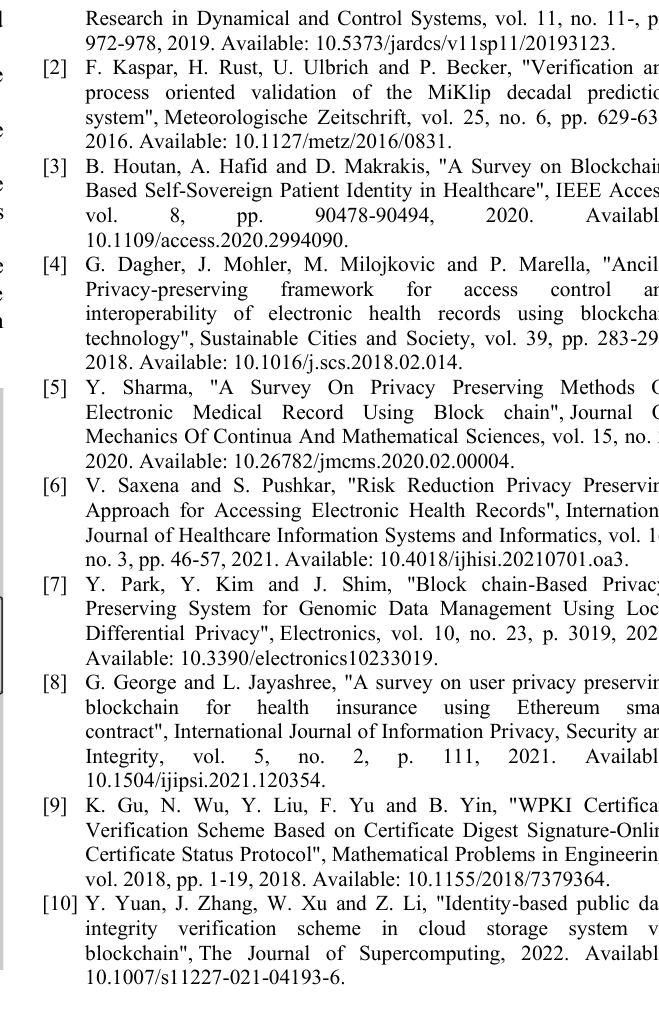
Figure 3: System